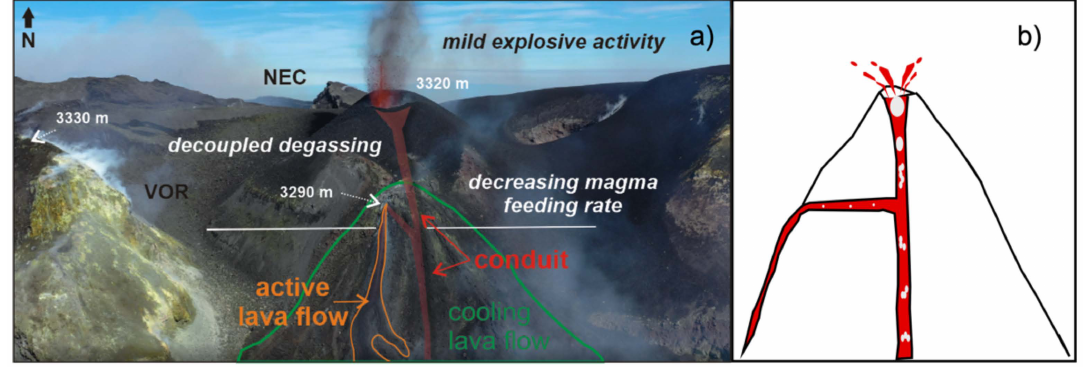
Figure 10. ( a ) Reconstruction of the activity monitored on Etna on 25 February 2020 and ( b ) sketch of the conduit